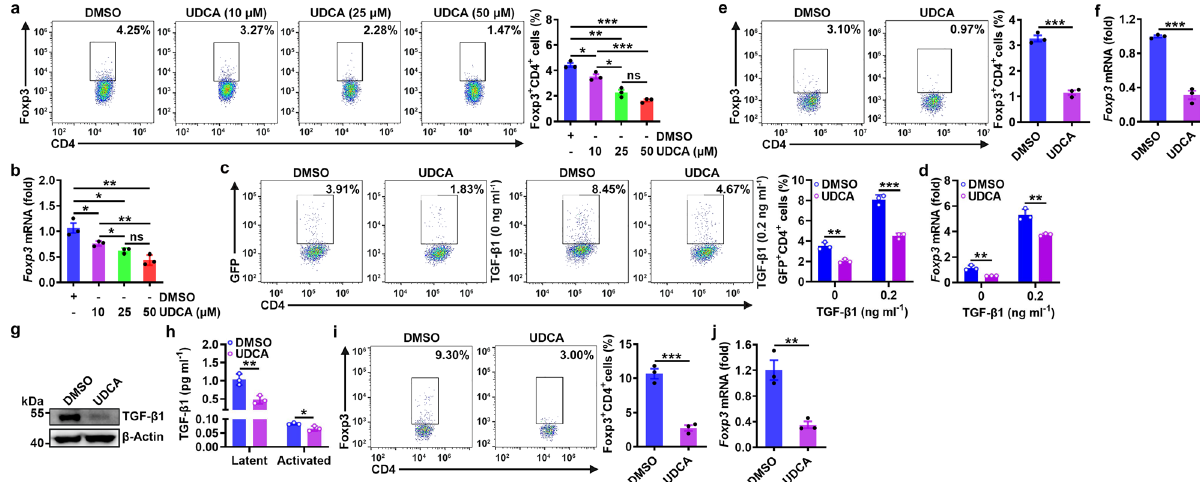
Fig. 2 UDCA inhibits Treg cell induction and function by reducing the TGF- β level. a , b FC analysis of Foxp3 + CD4 + T cells ( a ) and real-time PCR analysis of Foxp3 mRNA expression ( b ) in naïve CD4 + T cells stimulated with anti-CD3, anti-CD28, and the indicated concentration of UDCA for 3 days. c , d FC analysis of GFP + CD4 + T cells ( c ) and real-time PCR analysis of Foxp3 mRNA expression ( d ) in naïve CD4 + T cells from Foxp3 GFP mice stimulated with anti-CD3, anti-CD28, and 50 μ M UDCA in the absence or presence of the cytokine TGF- β 1 (0.2 ng ml − 1 ) for 3 days. e , f FC analysis of Foxp3 + CD4 + T cells ( e ) and real-time PCR analysis of Foxp3 mRNA expression ( f ) in naïve CD4 + T cells from OT-II mice stimulated with 2 μ g ml − 1 OVA 323 – 339 peptide plus T cell-depleted γ -irradiated splenic cells in the presence of 50 μ M UDCA for 3 days. g , h Immunoblot (IB) analysis ( g ) or ELISA ( h ) of TGF- β 1 in naïve CD4 + T cells stimulated with anti-CD3, anti-CD28, and 50 μ M UDCA for 24 h ( g ) or in the culture supernatant ( h ). i , j FC analysis of Foxp3 + CD4 + T cells ( i ) and real-time PCR analysis of Foxp3 mRNA expression ( j ) in naïve CD4 + T cells from OT-II mice cocultured with LLC-OVA cells in the presence of 50 μ M UDCA for 3 days. Representative results from two ( b , d , f , j ) or three ( a , c , e , g – i ) independent experiments are shown ( n = 3 in all statistical groups). * P < 0.05; ** P < 0.01; *** P < 0.001; ns, not signi fi cant (unpaired two-tailed Student ’ s t test; mean and s.d.). See Source Data fi le for the exact P